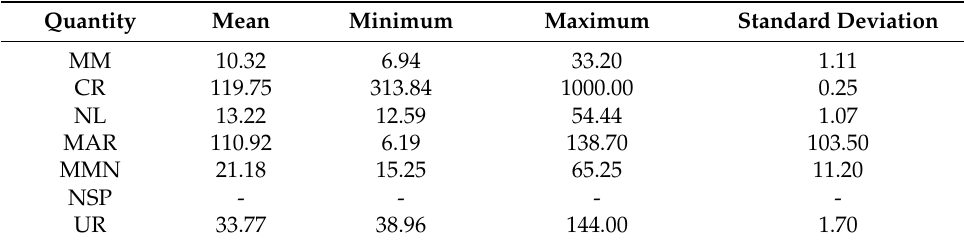
Table 1. Statistical analysis of the